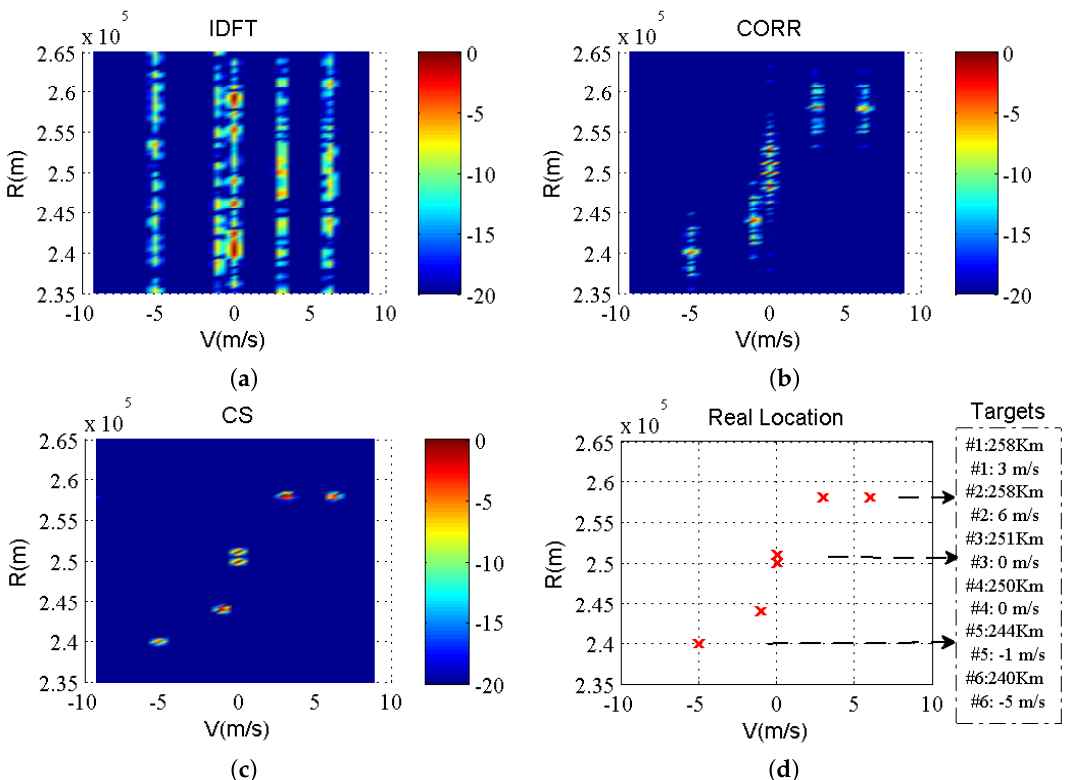
Figure 5. Target RD estimation with different method. ( a ) IDFT method; ( b ) Correlation function method; ( c ) compressive sensing method; ( d ) actual location of targets as a reference (The theoretical values of the actual range and velocity location are the discrete points in ( d ), which only provide references for estimation in ( a ) ( b ) and ( c